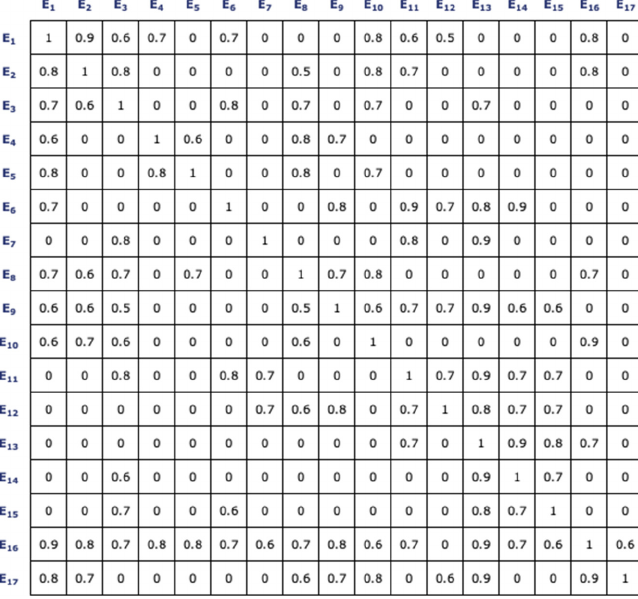
Figure A3. Matrix with a valuation of incidents between effects.